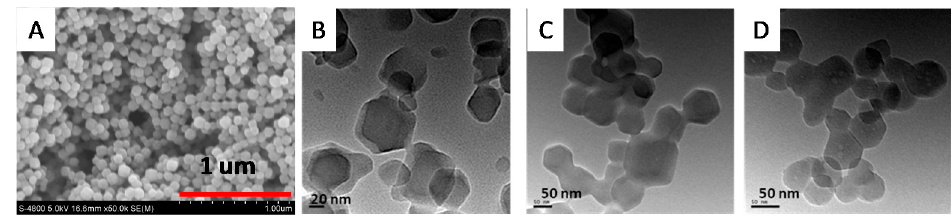
Figure 2. SEM images of fresh ZIF-8 ( A ) and TEM images of fresh ZIF-8 ( B , C ) and recovered ZIF-8 ( D ).